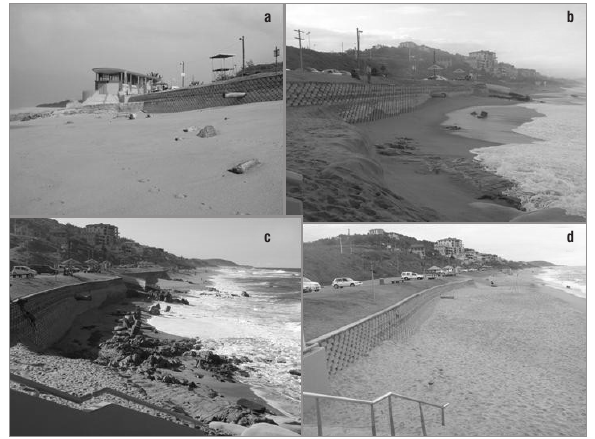
Figure 3: Westbrook Beach rotation on (a) 03 July 2011, (b) 10 July 2011, (c) 17 July 2011 (during an unusual ENE swell) and (d) 28 August